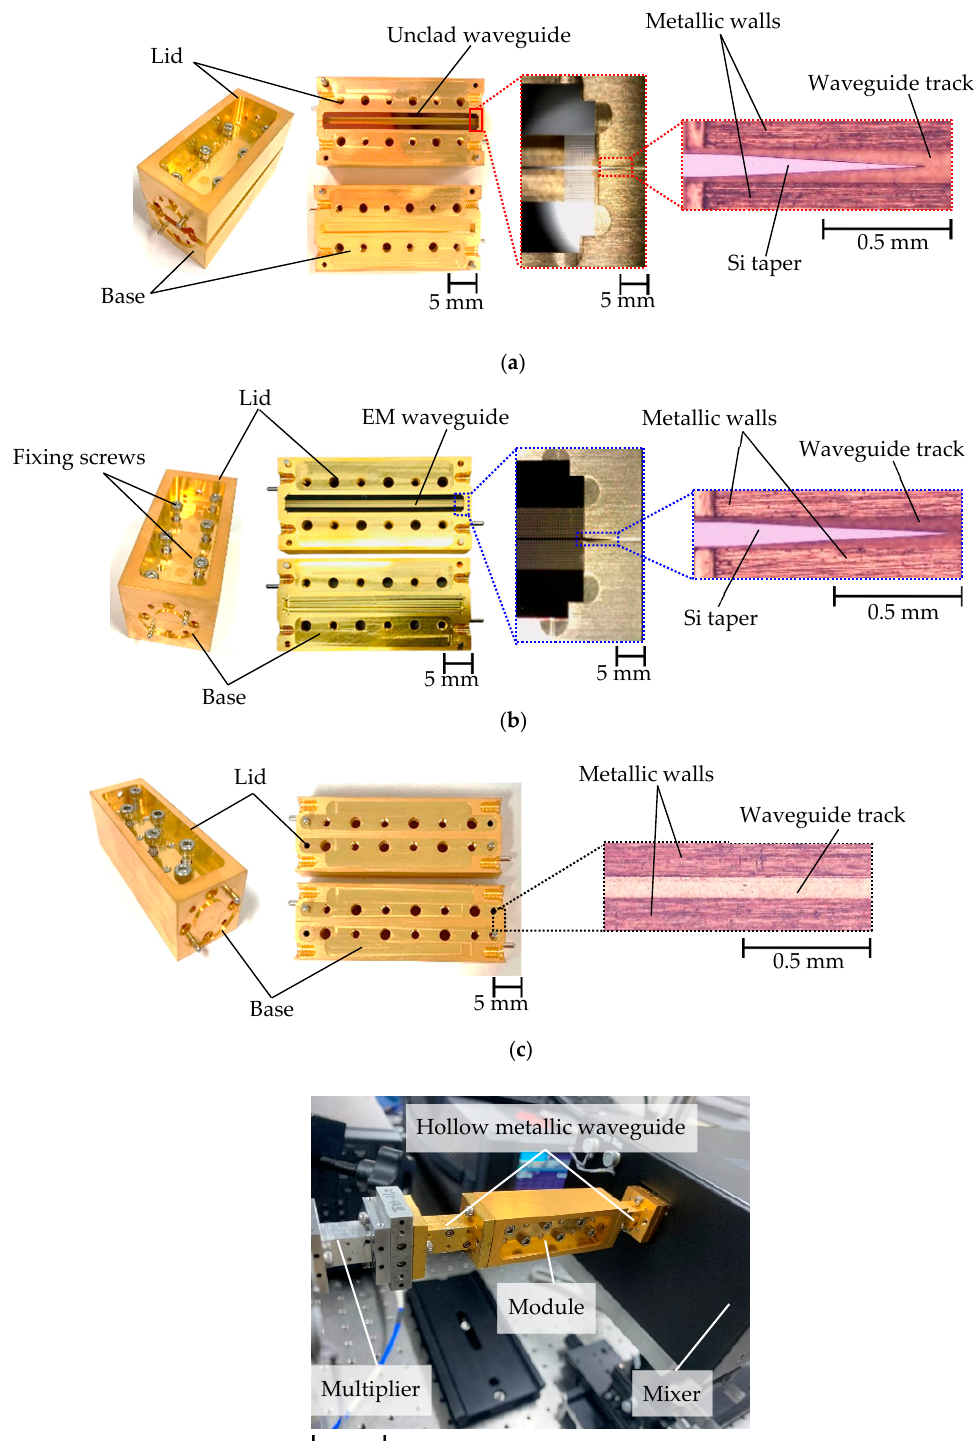
Figure 11. Fabricated modules and experimental setup: ( a ) Unclad waveguide module; ( b ) EM waveguide module; ( c ) Hollow metallic waveguide; ( d ) Experimental setup.